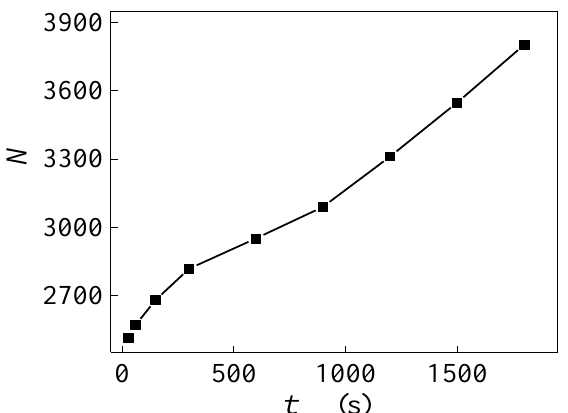
Figure 11. Effects of the power conversion time on the thermal fatigue lives of the key solder joints.